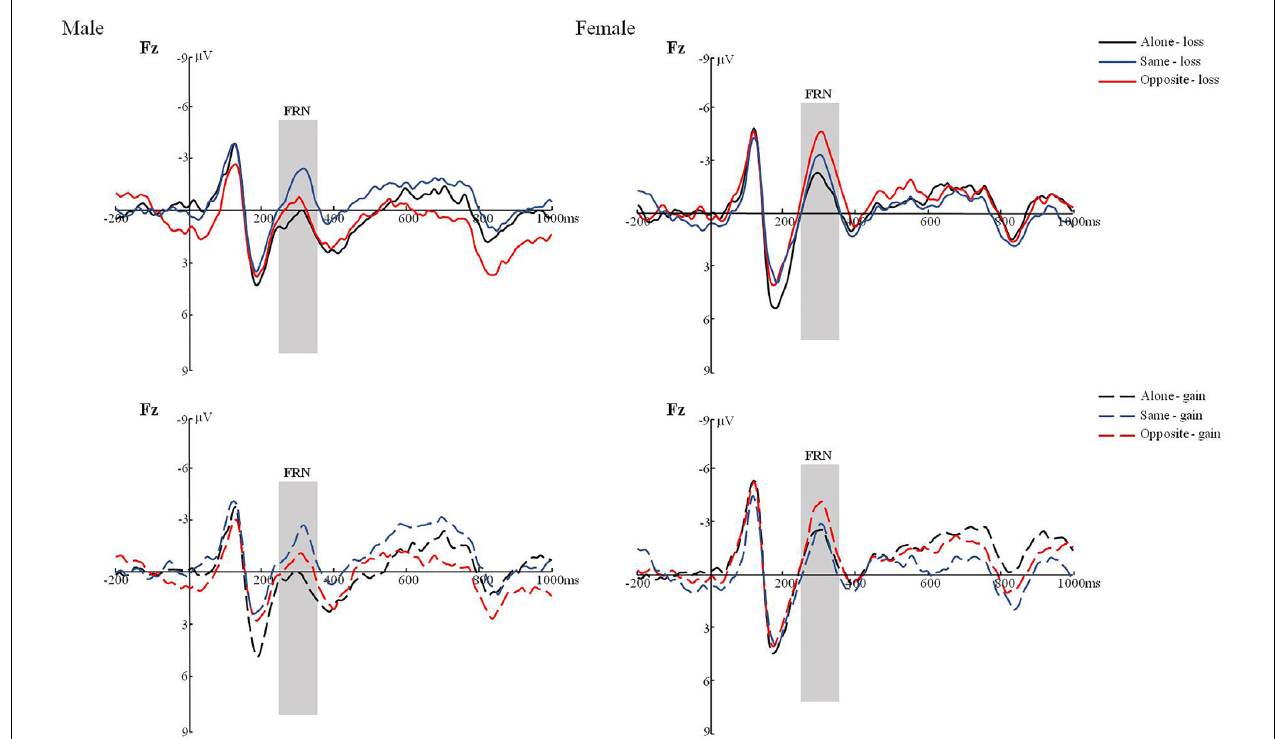
FIGURE 2 | The FRN of male/female under the condition of different joint task in